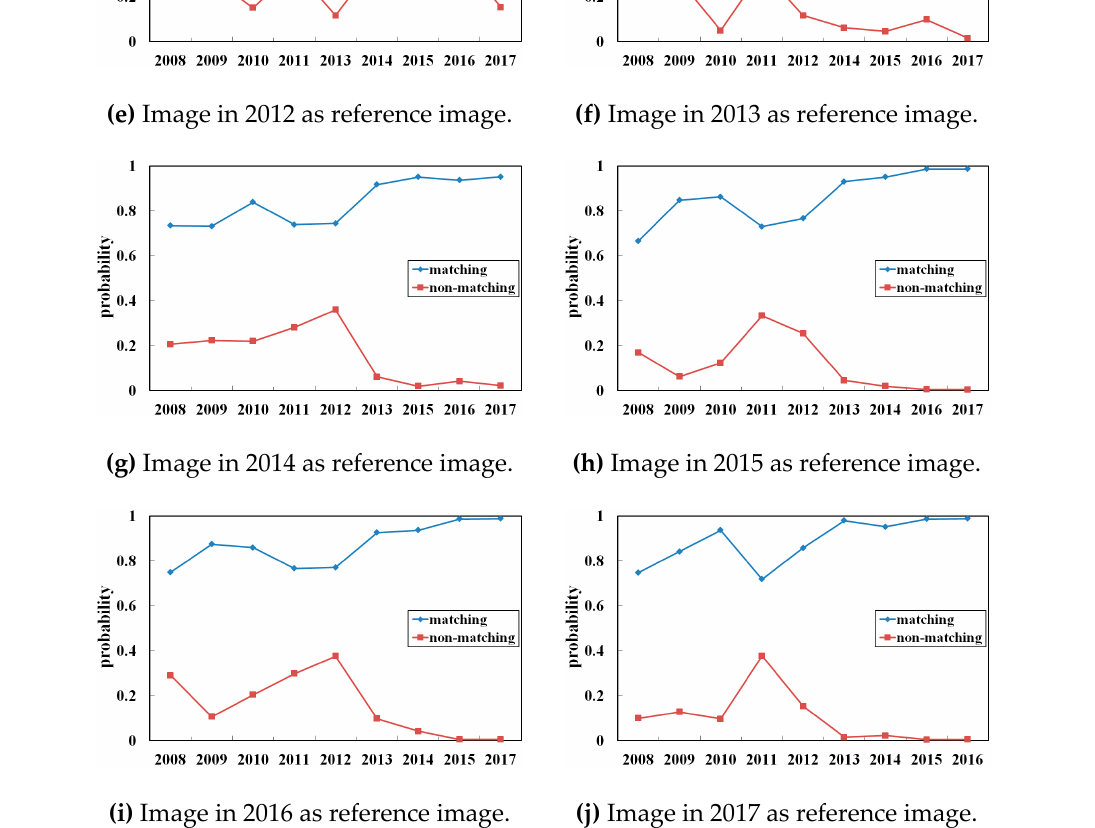
Figure 4. Matching and non-matching probabilities between multi-temporal remote image patches in Figure 3. ( a – j ) show the statistical results from 2008 to 2017.